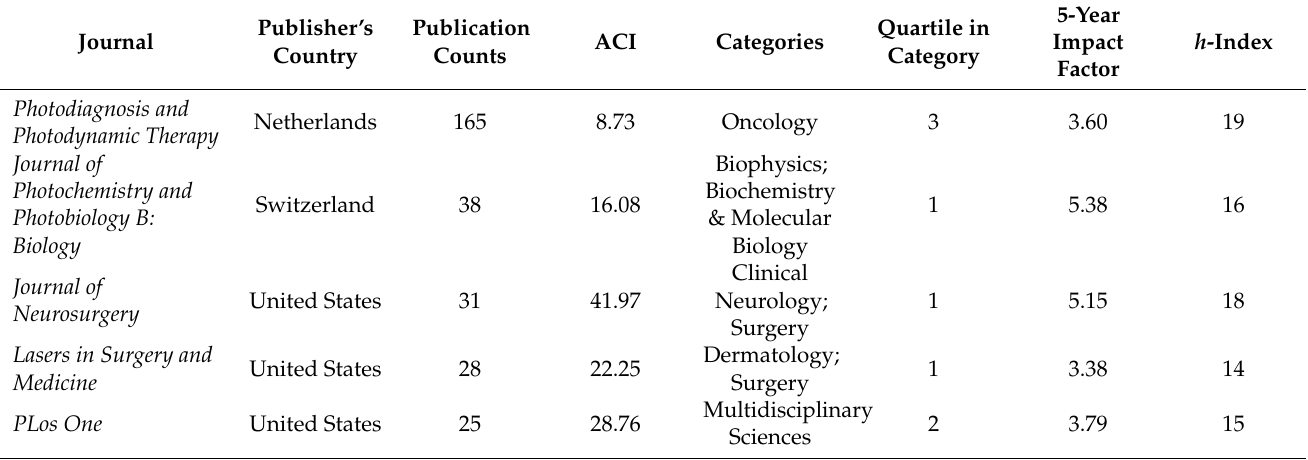
Table 2. Top 11 most active journals in the field of 5-ALA